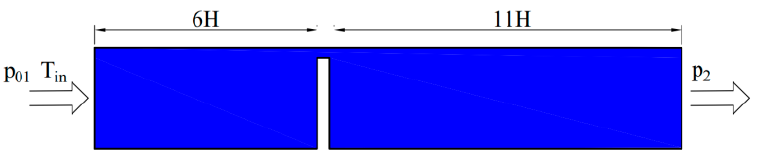
Figure 6. Calculation domain.